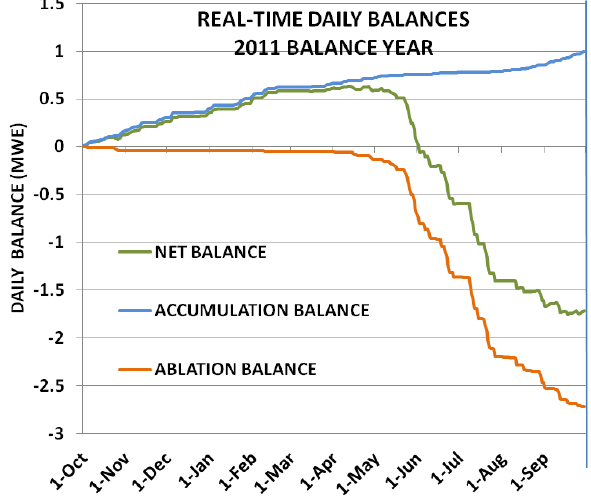
Figure 8a. Net, Accumulation and Ablation balances of Bering Glacier 348 as a function of elevation, averaged for the 1951-2011 period. The ELA 349 (1550 meters) is defined as the point at which the Net balance crosses 350 the zero balance line. 351 Figure 8b. Net, Accumulation and Ablation balances of Bering Glacier 355 Fig. 8. (a) Net, accumulation and ablation balances of Bering as a function of elevation, averaged for 2004. The ELA is 1850 meters, 356 Glacier as a function of elevation, averaged for the 1951–2011 pe- 300 meters above average. The balance at the terminus (-14 mwe) is 357 riod. The ELA (1550m) is defined as the point at which the net nearly 3 times as negative as on a normal year. 358 balance crosses the zero balance line. (b) Net, accumulation and 359 ablation balances of Bering Glacier as a function of elevation, av- eraged for 2004. The ELA is 1850m, 300m above average. The balance at the terminus ( − 14mw.e.) is nearly 3 times as negative as on a normal year.